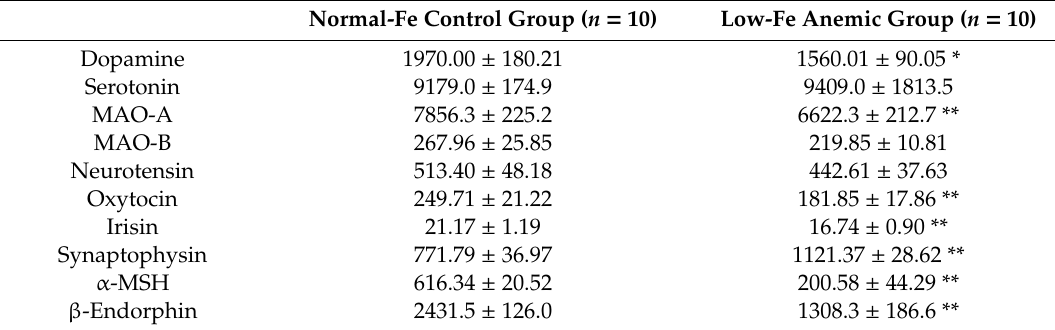
Table 3. Brain molecular function parameters in brain homogenate (pg mL − 1 ) from control and anemic rats (pre-experimental